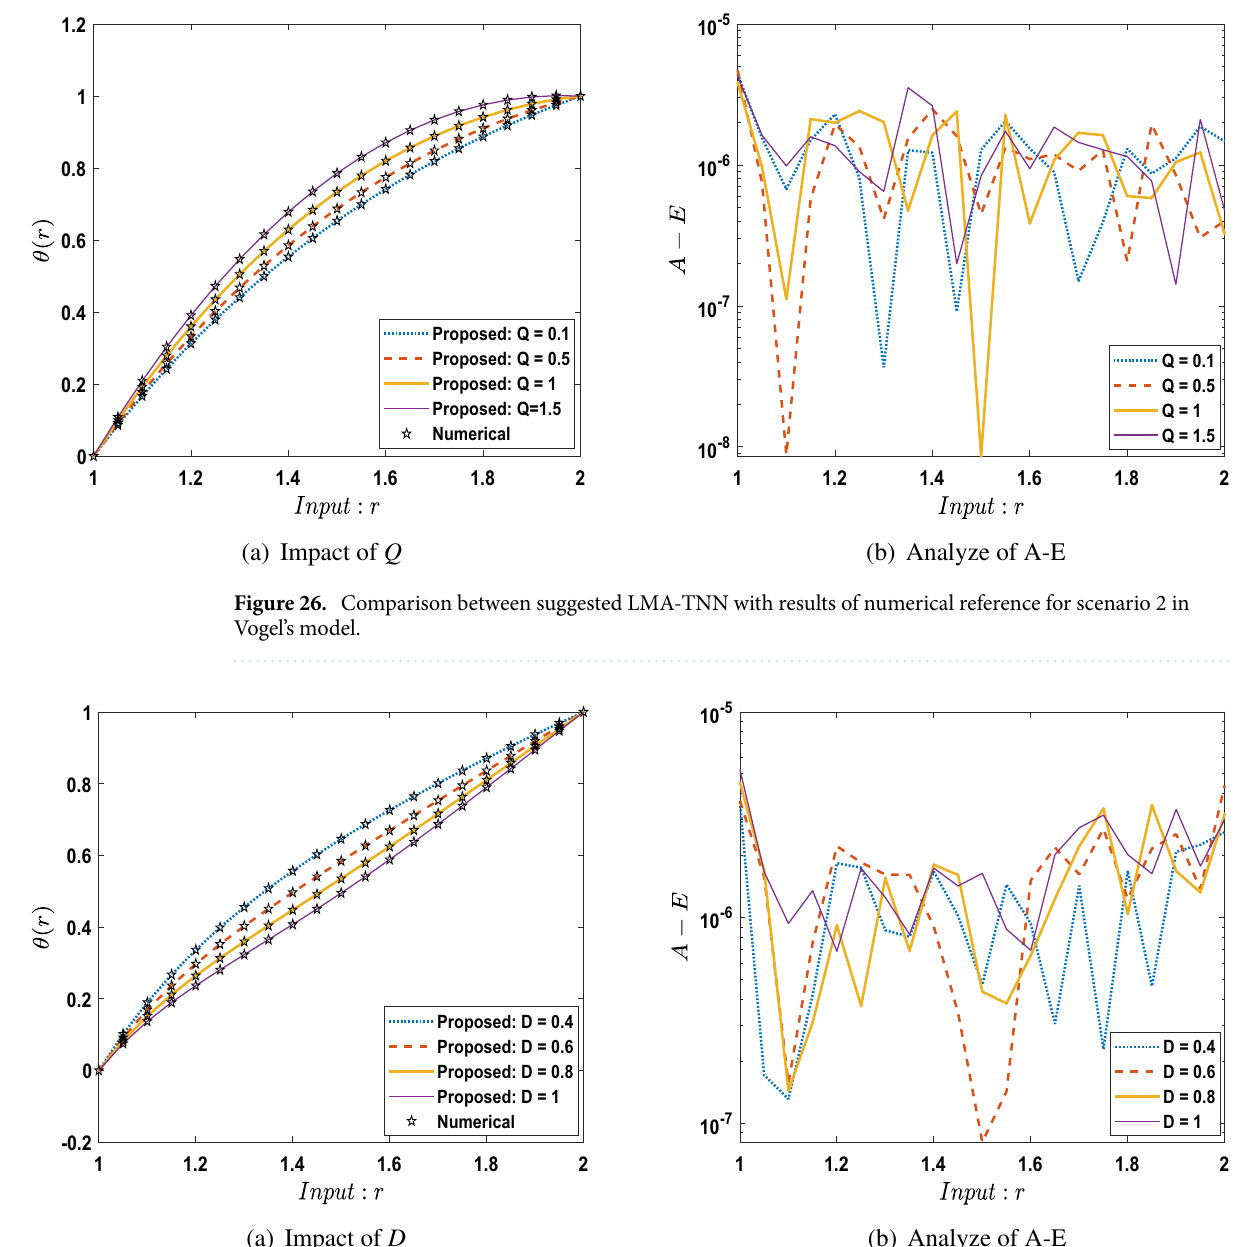
Figure 27. Comparison between suggested LMA-TNN with results of numerical reference for scenario 3 in Vogel’s